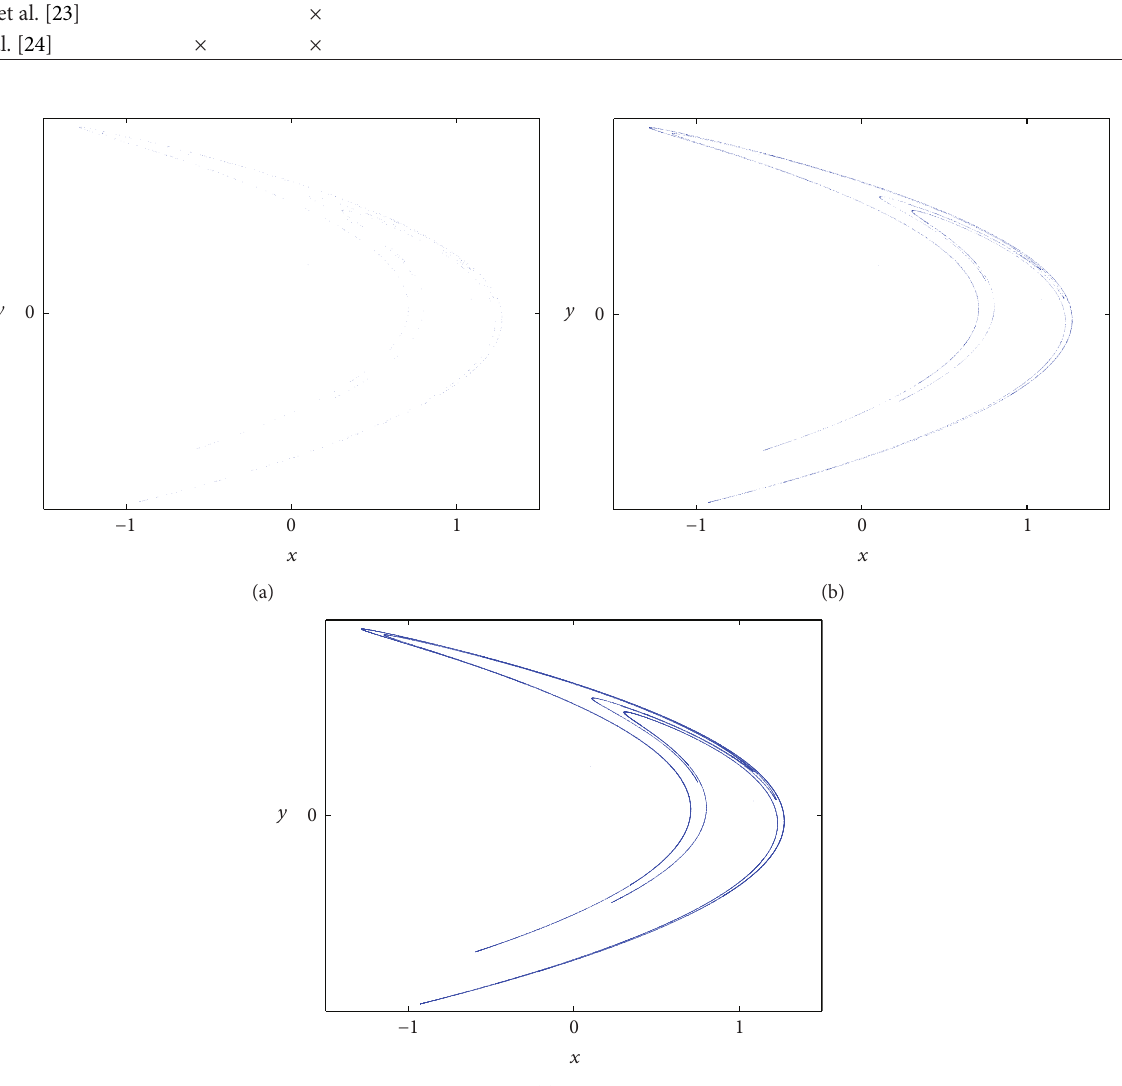
Figure 1: Henon map attractor after (a) 500, (b) 5000, and (c) 50000 iterations with initial parameters 𝛼 = 1.4 and 𝛽 = 0.3 and initial point (0.1, 0.1)